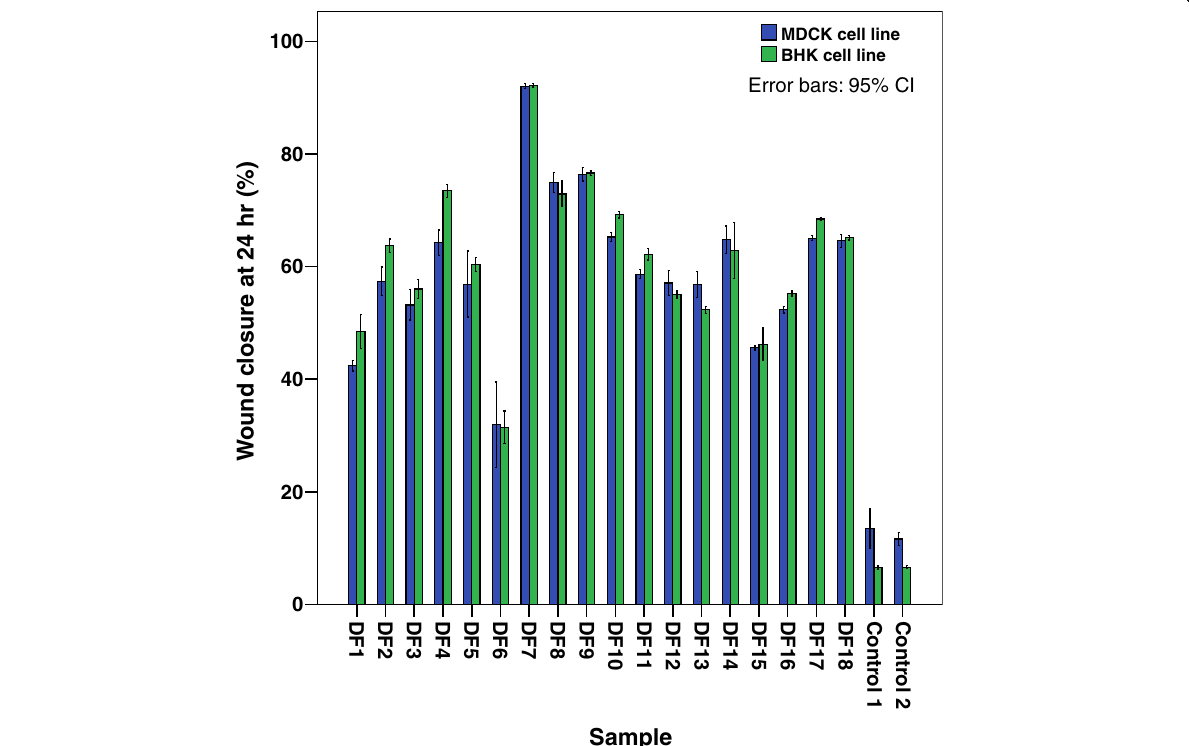
Fig. 3 Percentage wound closure in the presence of column fractions of F. racemosa DCM extract on BHK and MDCK cell lines. (Bars represent the mean and confidence intervals of 95% of nine measurements in the three